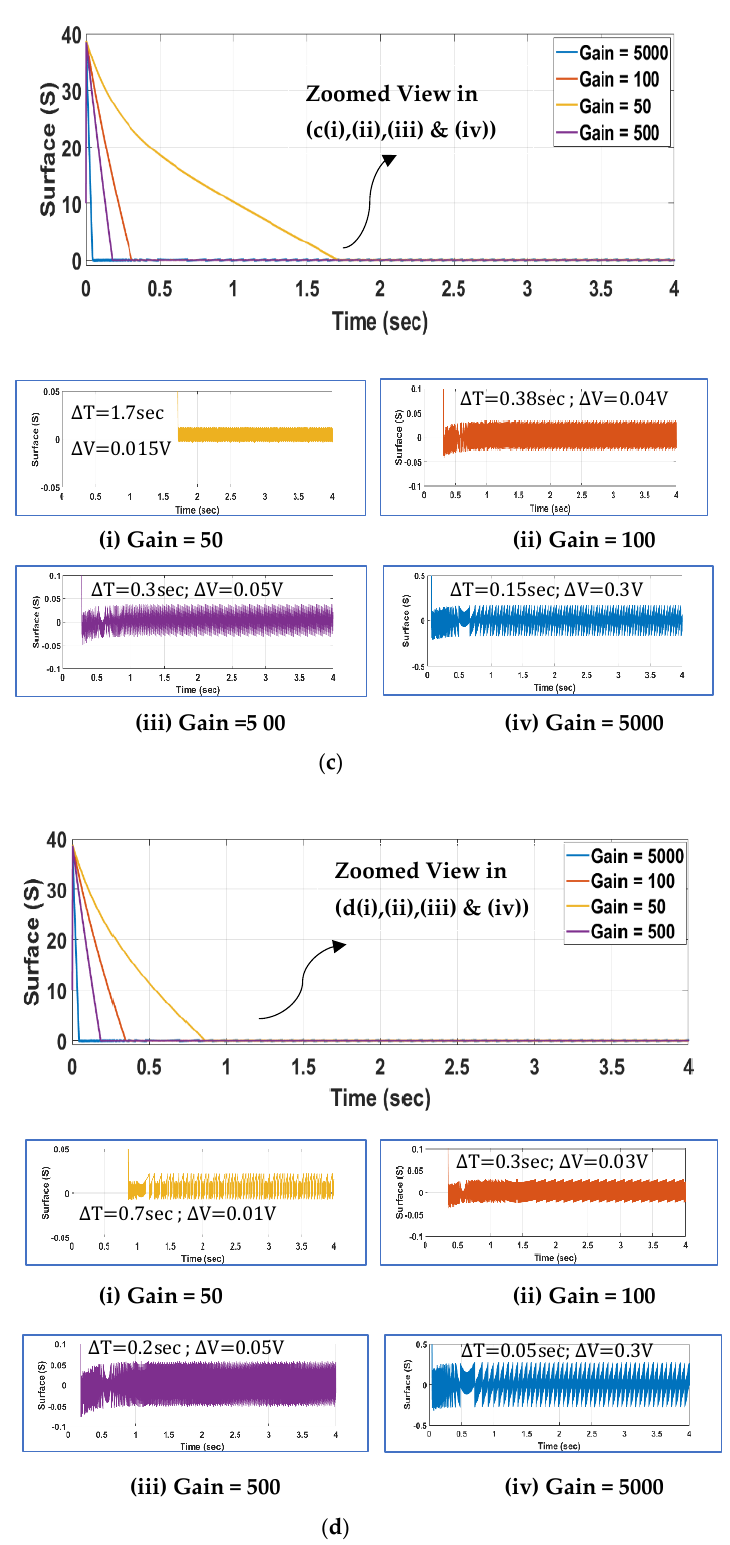
Figure 4. ( a ) PRERL-reaching law behavior at different gain values. Zoomed view to analyze the chattering and reaching time at 50, 100, 500, and 5000 gain values at ( i ), ( ii ), ( iii ), and ( iv ), respectively. ( b ) RRL-reaching law behavior at different gain values. Zoomed view to analyze the chattering and reaching time at 50, 100, 500 and 5000 gain values at ( i ), ( ii ), ( iii ), and ( iv ), respectively. ( c )